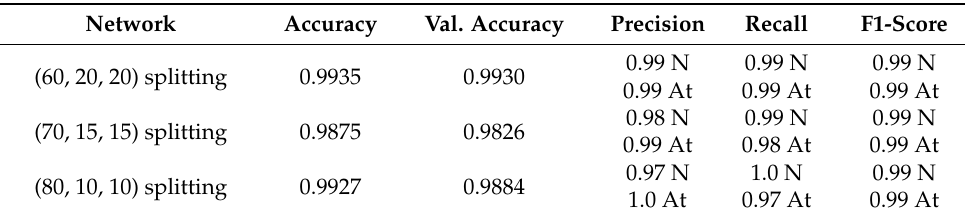
Table 4. DDoS detection results under the BDLSTM-autoencoder model for three different train-test- validate data splits.